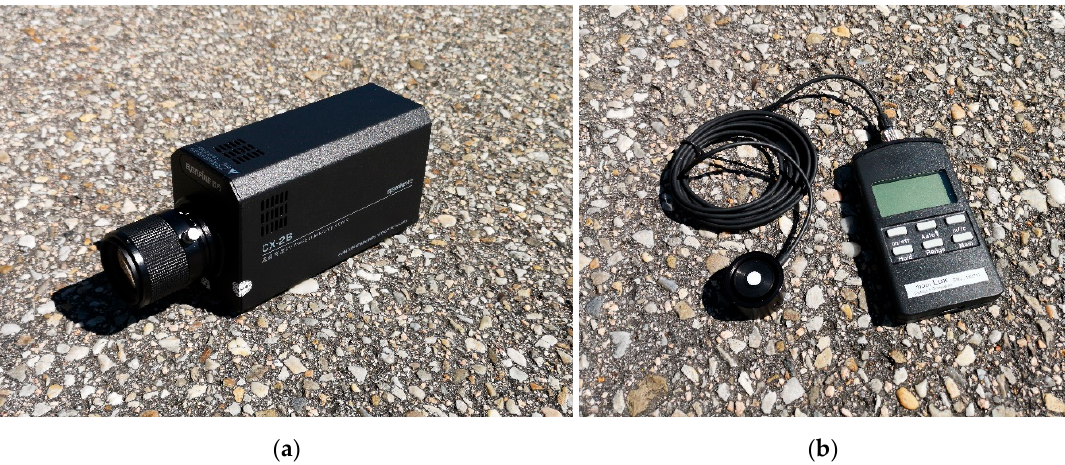
Figure 4. Measurement equipment used to collect luminance and illuminance data: ( a ) CX-2B imaging luminance meter; ( b ) Mobilux luxmeter.